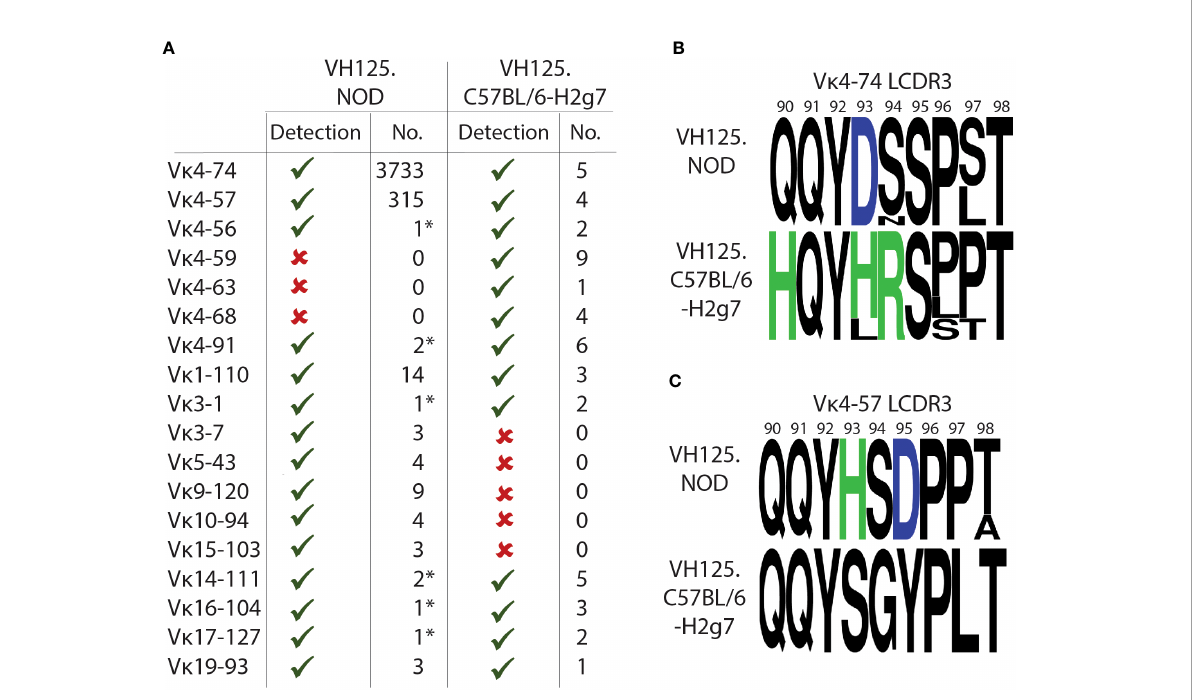
FIGURE 4 High-af fi nity IBCs of VH125.C57BL/6-H2g7 express unmutated and polymorphic Ig k chains. (A) Comparison of V k gene segments from splenic high-af fi nity IBCs of prediabetic VH125.NOD with degenerate primers (denoted by asterisk *) and by scRNA-seq as well as of VH125.C57BL/6- H2g7 with degenerate primers. V k presence (green check mark), absence (red cross) and the number of unique sequences detected are provided. (B, C) Amino acid composition of Ig k CDR3 for V k 4-74 (B) and V k 4-57 (C) in high-af fi nity IBCs of prediabetic VH125.NOD and VH125.C57BL/6-H2g7. Neutral amino acids marked in black, positively charged H (histidine) and R (arginine) in green, negatively charged D (aspartic acid) in